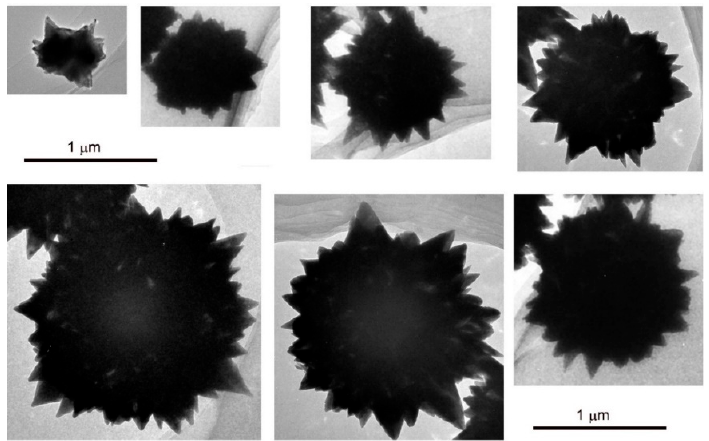
Figure 10. TEM image of the nanohorn-containing spheres of different sizes found in the products in a 200 mL NaOH solution (15 M) containing 3 mL of EDA.